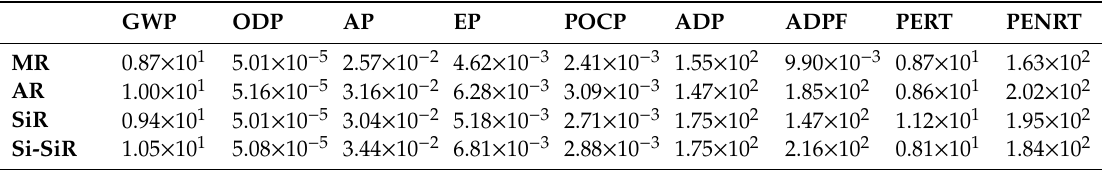
Table 3. The environmental characteristic for 1 m 2 of ETICS with and the 10 cm thickness of expanded polystyrene. Data from the EPD, according to the production of the ETICS system in the year 2017 [25].